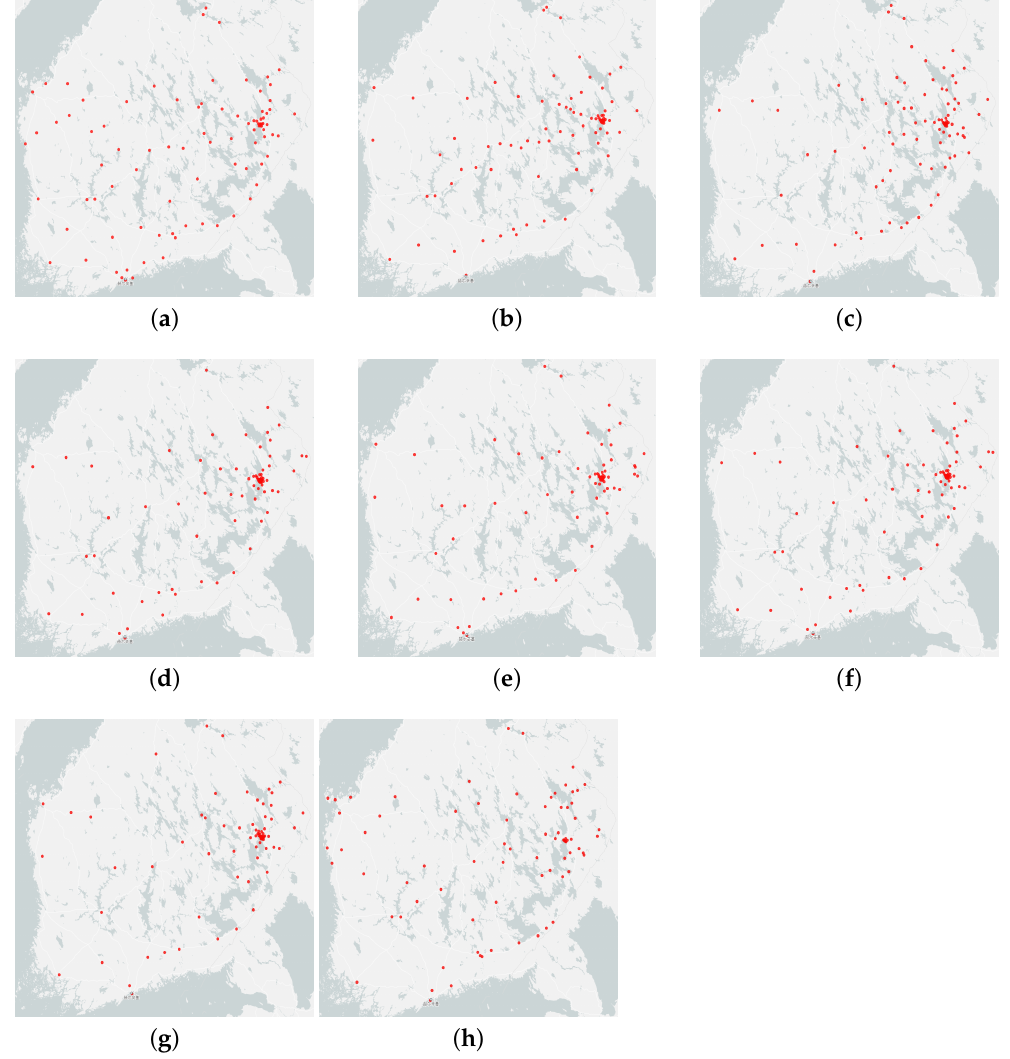
Figure 20. The urban hotspots in multi-source trajectory data set. ( a ) K-Means++; ( b ) GAK; ( c ) PSO- GAK; ( d ) PSOCK; ( e ) PSOK; ( f ) PSOWK; ( g ) RS; ( h )